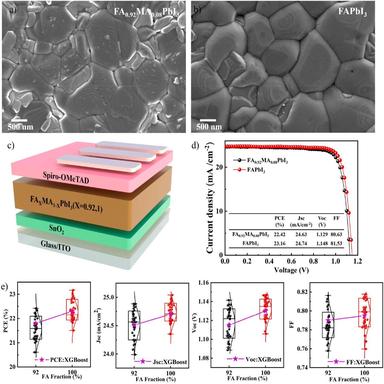
a)-b) top-view SEM of perovskite films (FA0.92MA0.08PbI3 and FAPbI3. c) device structure. d) J–V curves of optimal performance device in reverse scan. e) Photovoltaic parameter distribution statistics and predicted values of ML characterization (based on XGBoost algorithm) under different FA fraction.